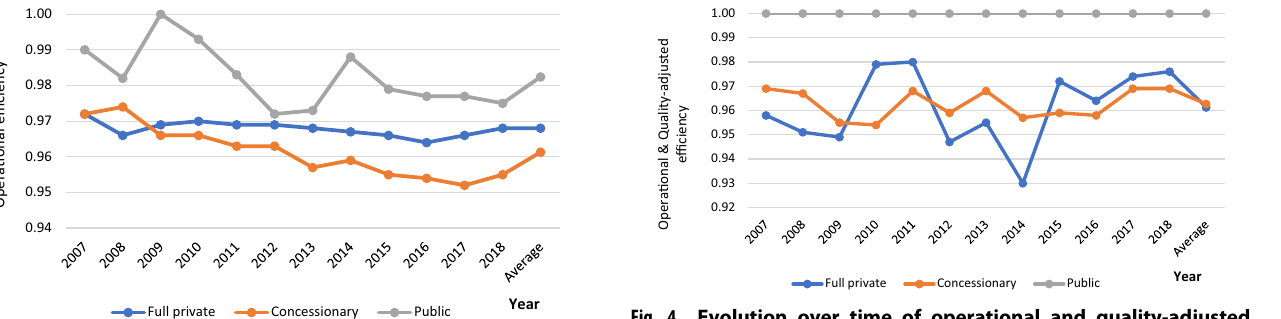
Fig. 4 Evolution over time of operational and quality-adjusted ef fi ciency of Chilean full private, concessionary and public water utilities. The trend in operational and quality-adjusted ef fi ciency based on the type of water